Question: In one sentence, what is this figure communicating?
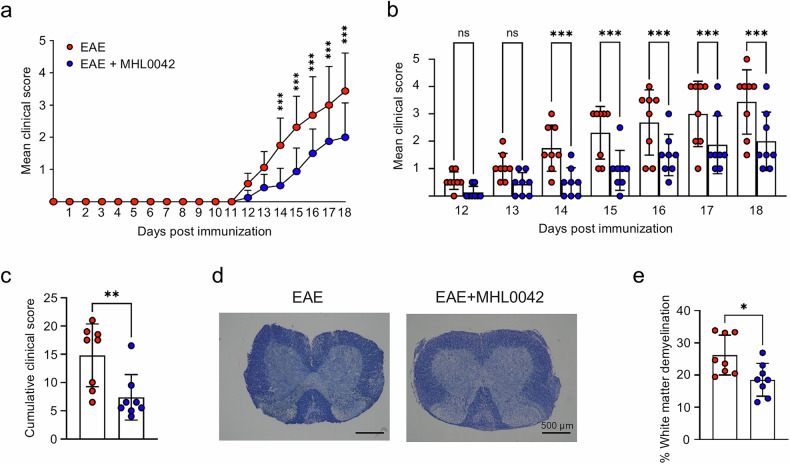
Answer: Administration of Veillonella ratti MHL0042 protects mice from developing severe experimental autoimmune encephalomyelitis. a , b Mean clinical scores of experimental autoimmune encephalomyelitis (EAE) mice treated with or without V. ratti MHL0042 from the day of EAE induction to 18 days post-immunization. c Cumulative clinical scores of EAE mice with or without V. ratti MHL0042 treatment. d Representative Luxol fast blue staining of myelin in spinal cord sections. e Quantification for the percentage of white matter demyelination in the spinal cord. Results are expressed as mean ± standard deviation from EAE ( n = 8) and EAE + V. ratti MHL0042 ( n = 8) groups, * P < 0.05; ** P < 0.01; *** P < 0.001. ns, not significant.